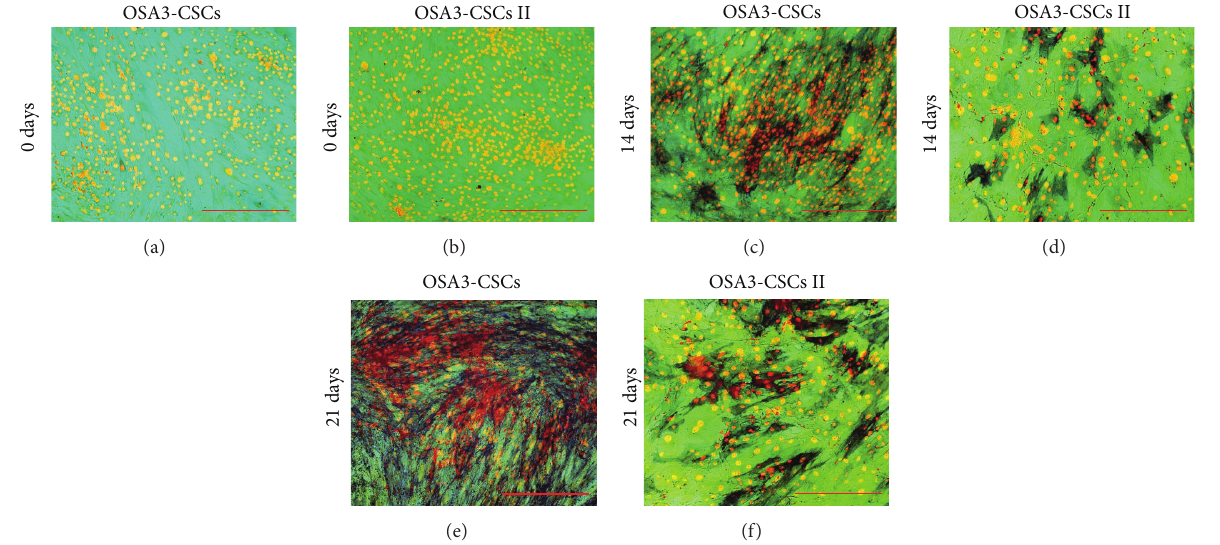
Figure 18: Osteogenic differentiation on OSA3-CSCs and on OSA3-CSCs II lines ALP. Osteogenic differentiation at 0 days (a-b), after 14 days (c-d), and after 21 days of induction by a cytochemical staining for the ALP with Fast Blue BB. In blue the ALP + cells and in red the nucleus counterstained by Propidium Iodide. Composite observation in brightfield and in fluorescence. Original magnifications: 20x. Bar size: 100 𝜇 m.